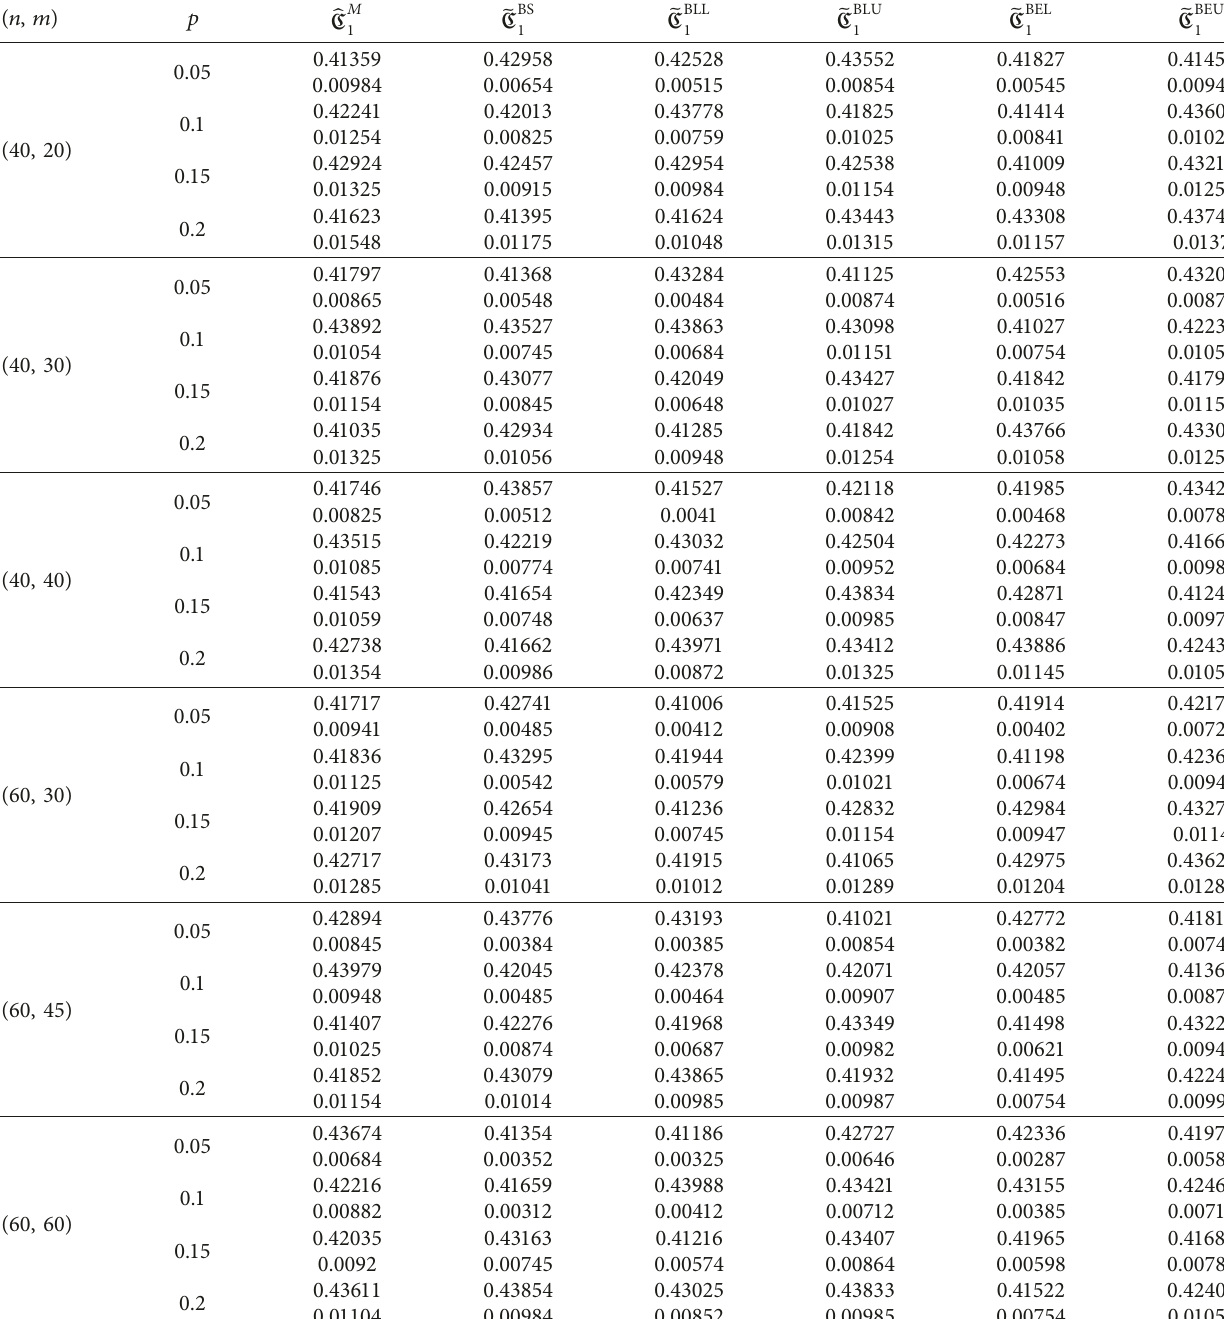
with respected MSE’s for different values of p and m for n 1